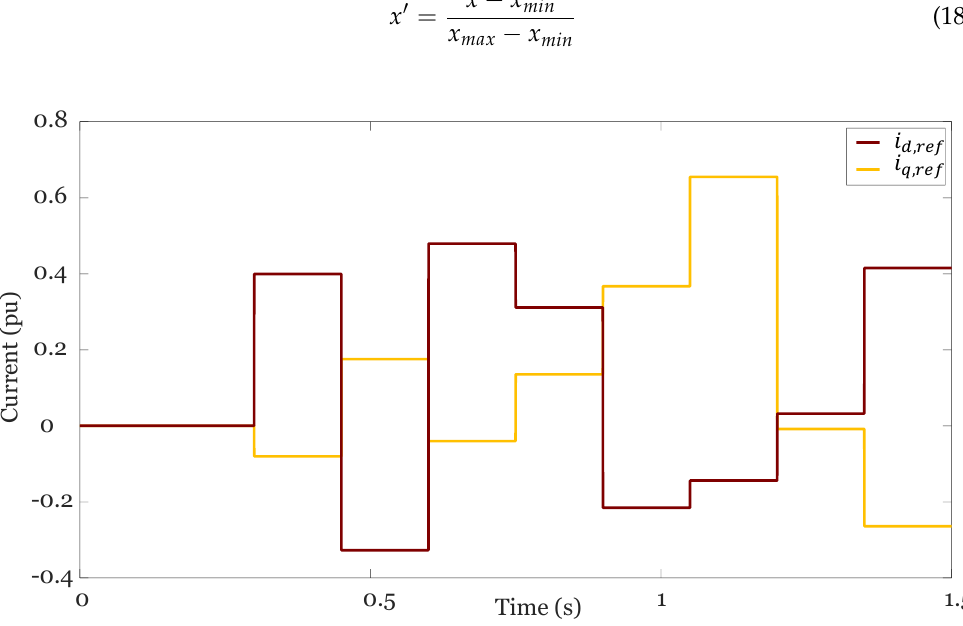
Figure 5. Example training data for LSTM